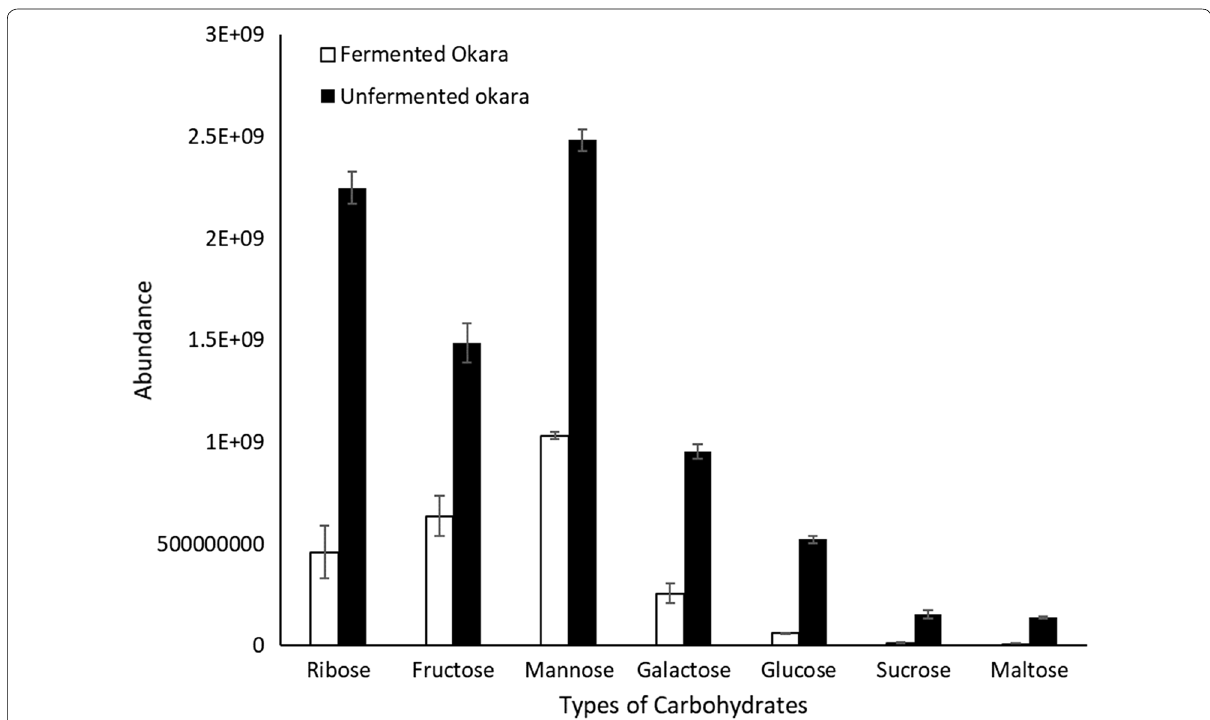
Fig. 3 Abundance of all the carbohydrates detected during